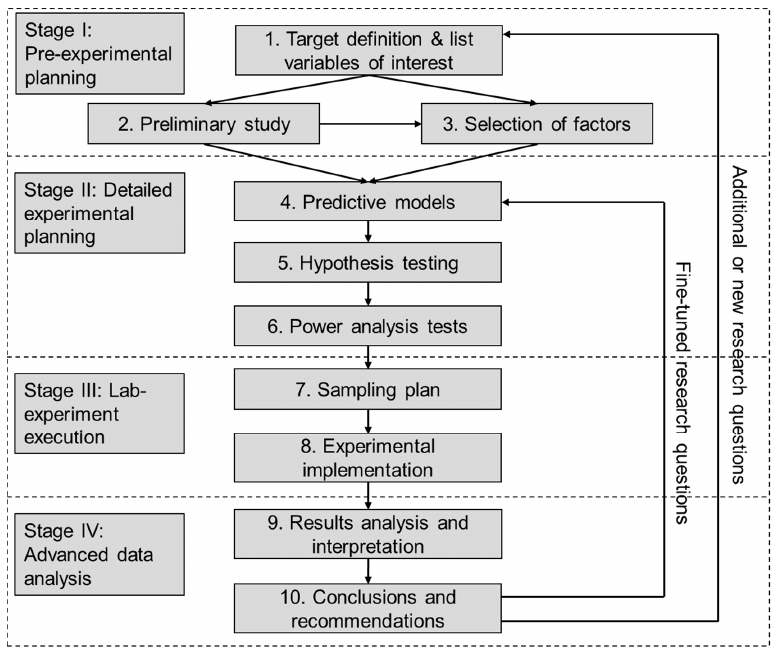
Figure 2. Main structure of the protocol. The protocol includes two feedback loops that allow for new research objectives or research questions, leading to further